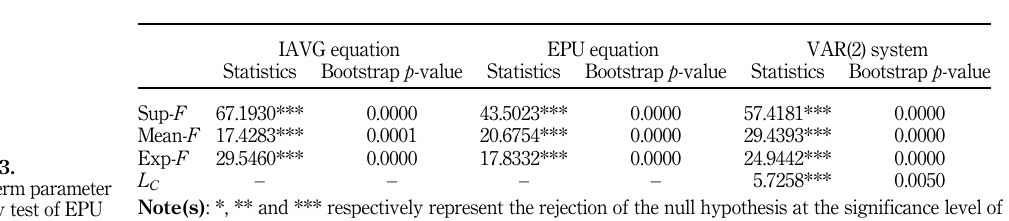
Table 2. Full-sample bootstrap rolling window causality test between EPU and IAVG